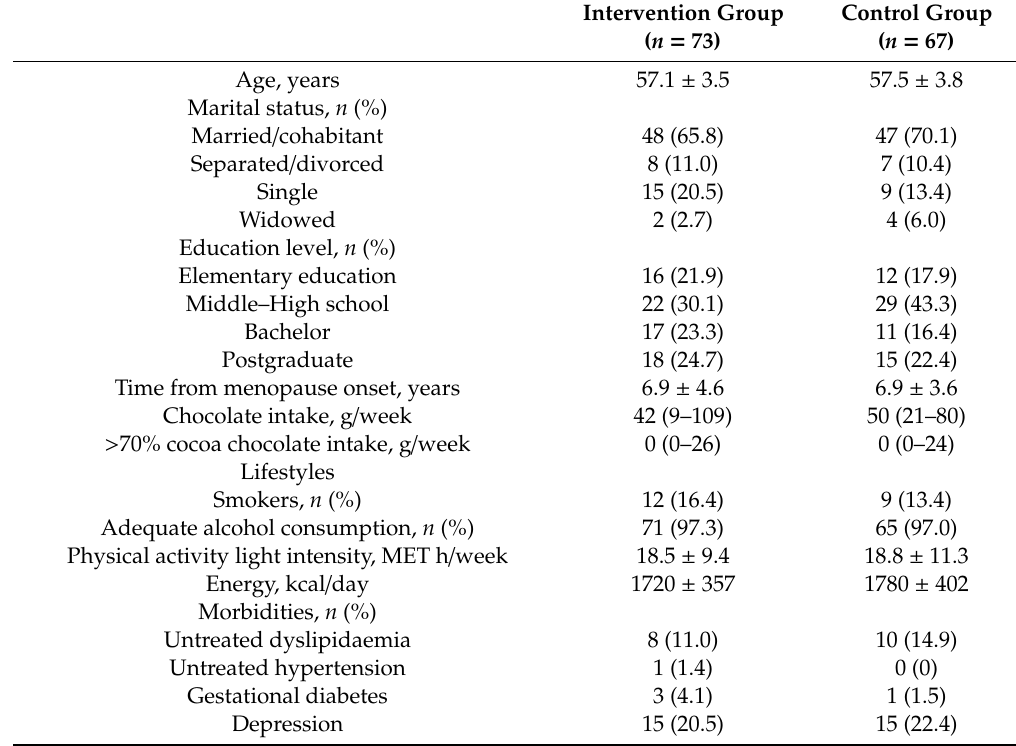
Table 1. Baseline characteristics of postmenopausal women participants in the